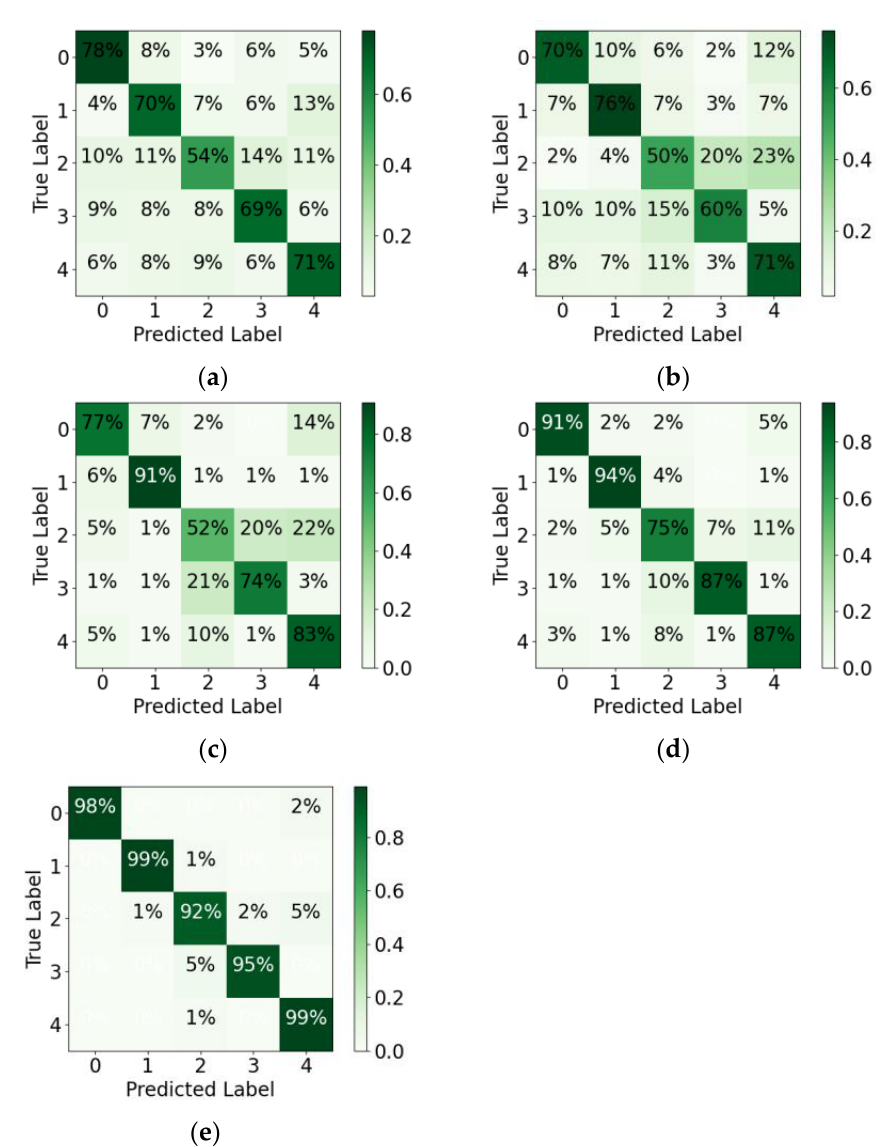
Figure 13. Confusion matrices for different networks in ablation experiments: ( a ) 1D CNN; ( b ) LSTM; ( c ) 1D CNN-LSTM; ( d ) LSTM-Attention; ( e ) CLA. Table 3. Performance comparison of ablation